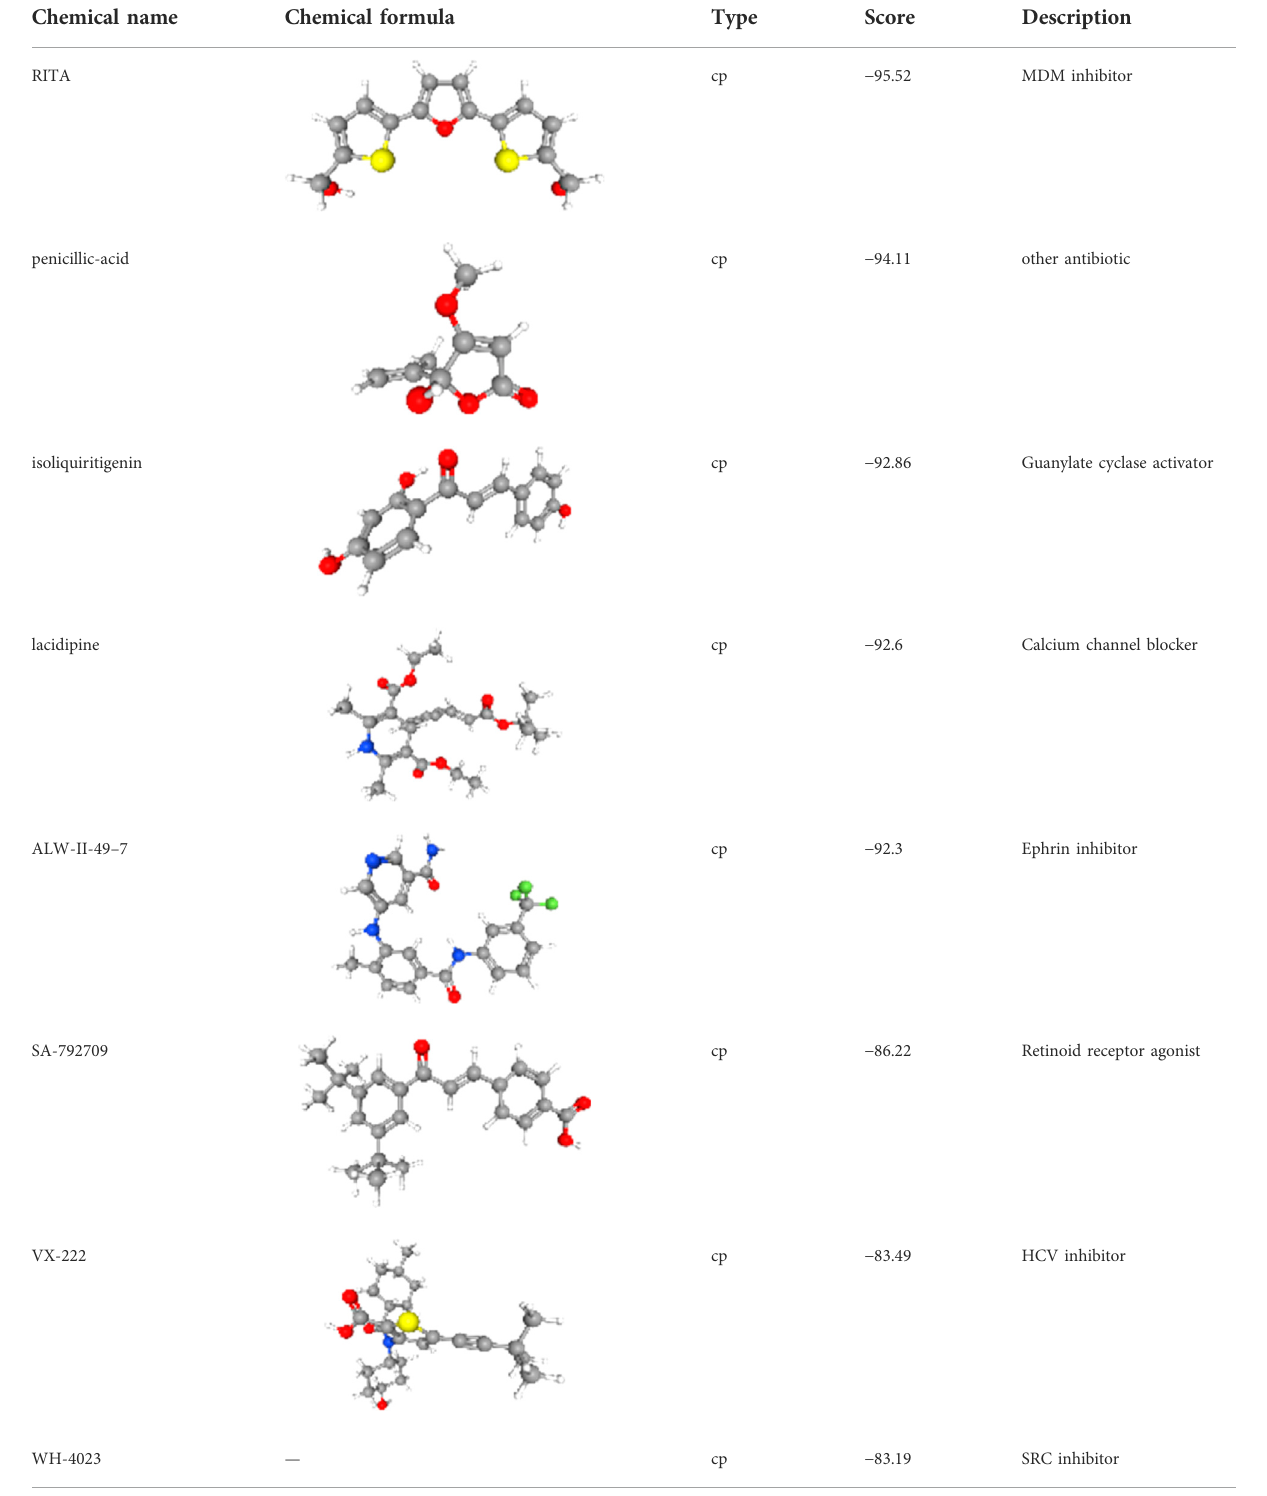
TABLE 3 Ten compounds identi fi ed as potential GDM